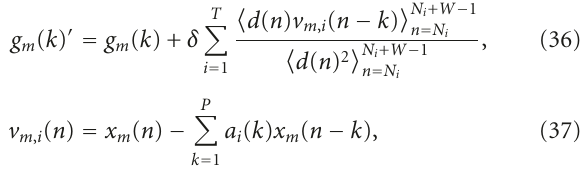
Figure 3: Room layout.